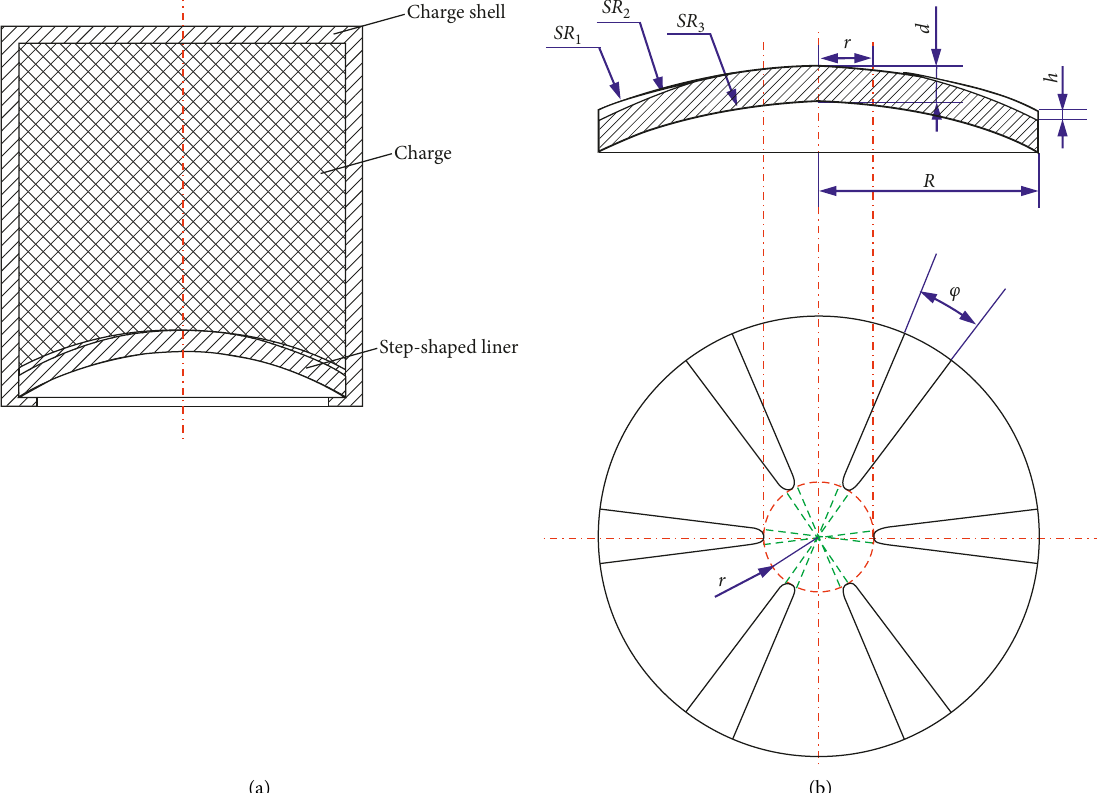
Figure 2: Schematic diagram of the shaped charge (a) and schematic diagram of the step-shaped liner (b).